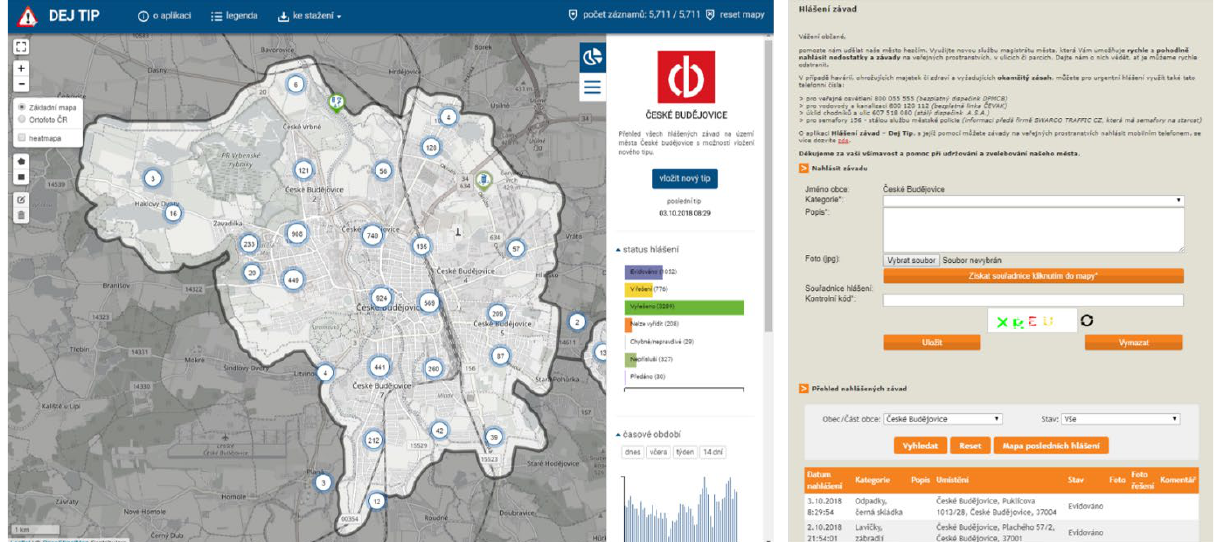
Figure 4. Two communication channels in České Budějovice (webGIS and electronic